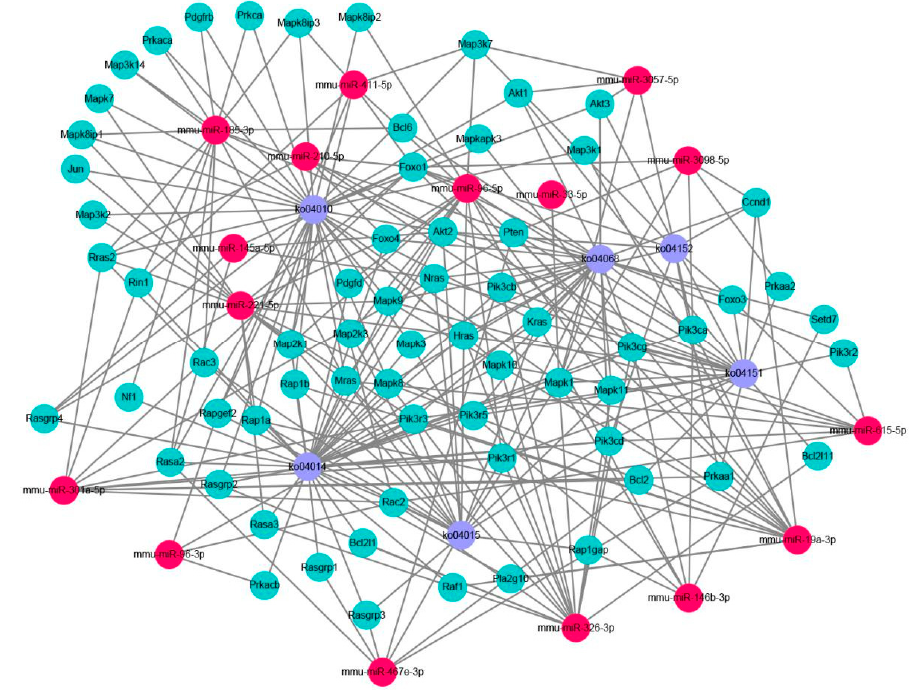
Figure 4. The miRNA-gene-pathway interactive map. Red indicates miRNA, light green indicates target gene, and purple indicates signal pathway. The signal path uses the following ko codes: ko04014 (Ras signalling pathway), ko04015 (Rap1 signalling pathway), ko04151 (PI3K-AKT signalling pathway), ko04068 (Foxo signalling pathway), ko04152 (AMPK signalling pathway), and ko04010 (MAPK signalling pathway).